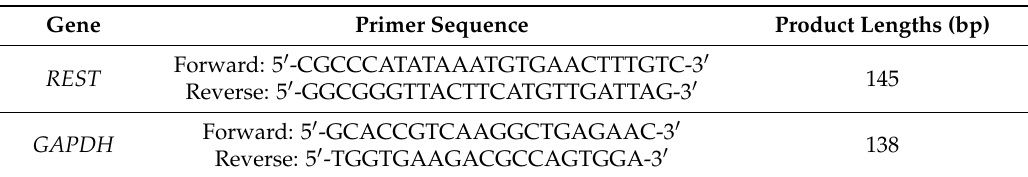
Table 1. Primer sequences for real-time